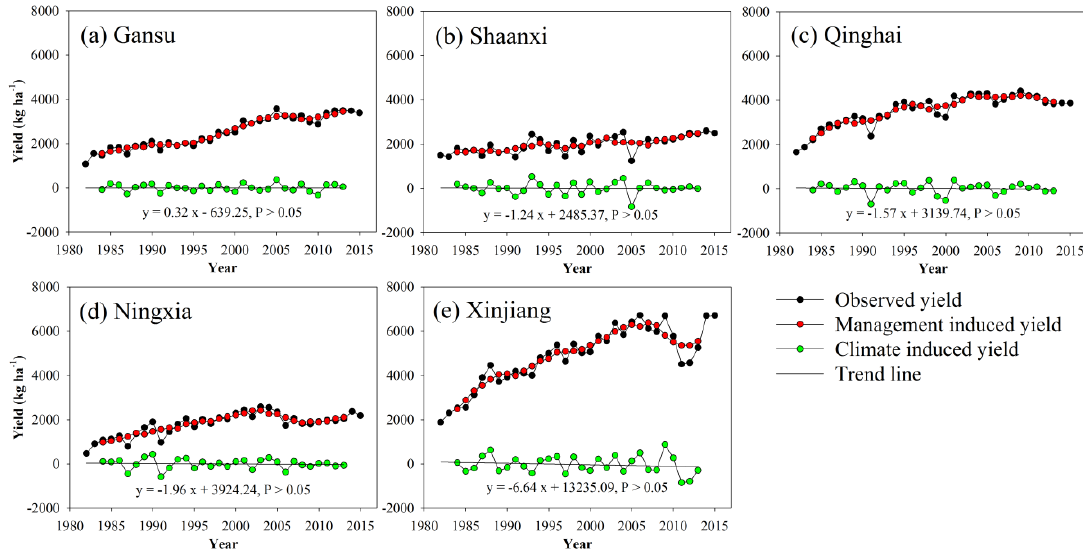
Figure 8. Changes in potato observed yield, management-induced yield and climate-induced yield in different provinces of northwest China.